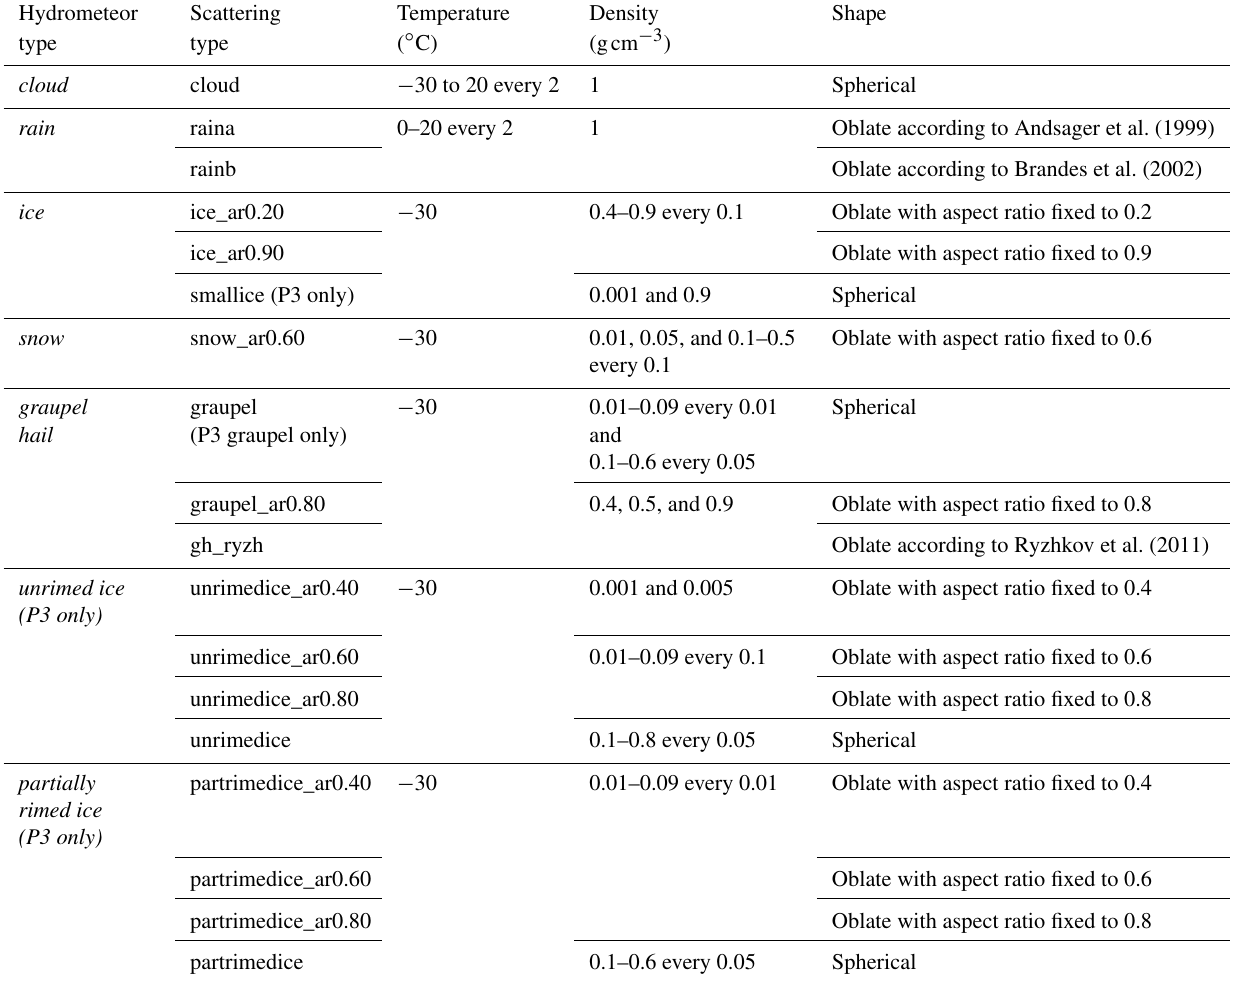
Table 2. Scattering types built in the current LUTs and settings for the scattering calculations. Diameter ranges are the same as shown in Table